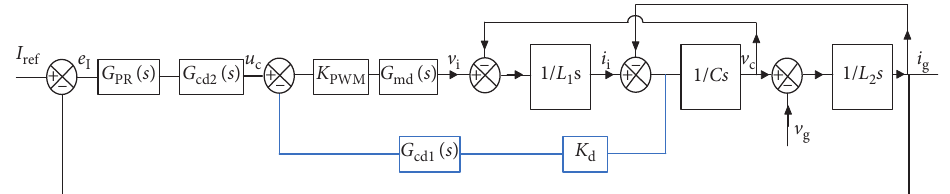
Figure 4: Block diagram of the control system including delay with AD by measuring capacitor